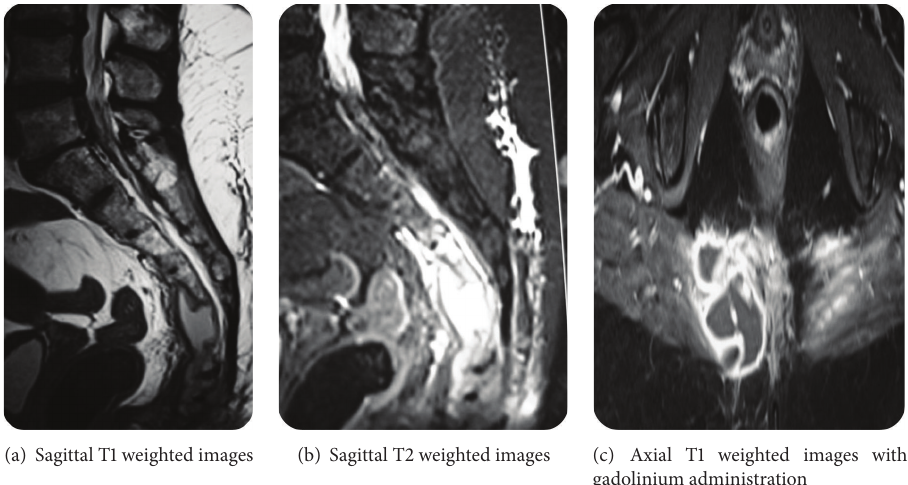
Figure 3: Magnetic resonance images of the patient. Revealing a process of hypointense signals in T1W images (a) and hyperintense signals in T2W images (b), the lesion was moderately enhanced in its periphery after gadolinium administration (c).